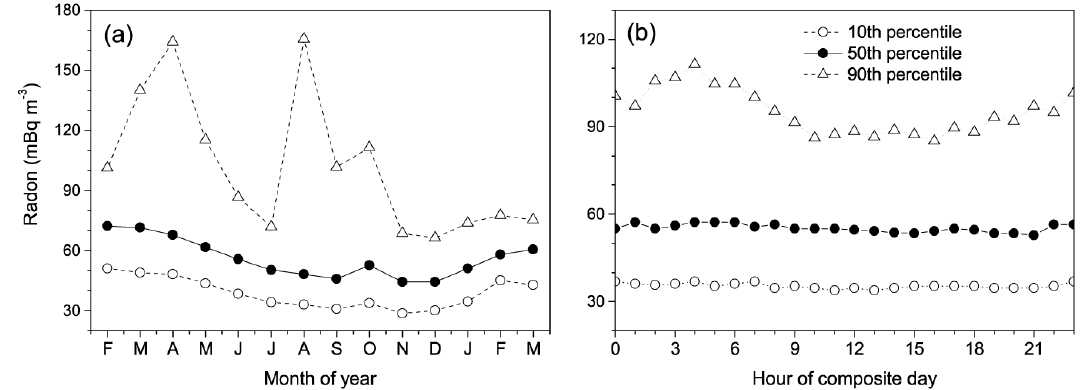
Figure 5. (a) Monthly distributions (10th, 50th and 90th percentiles) of hourly radon concentration, and (b) hourly distributions of composite diurnal values at KSG from February to October, 2013.